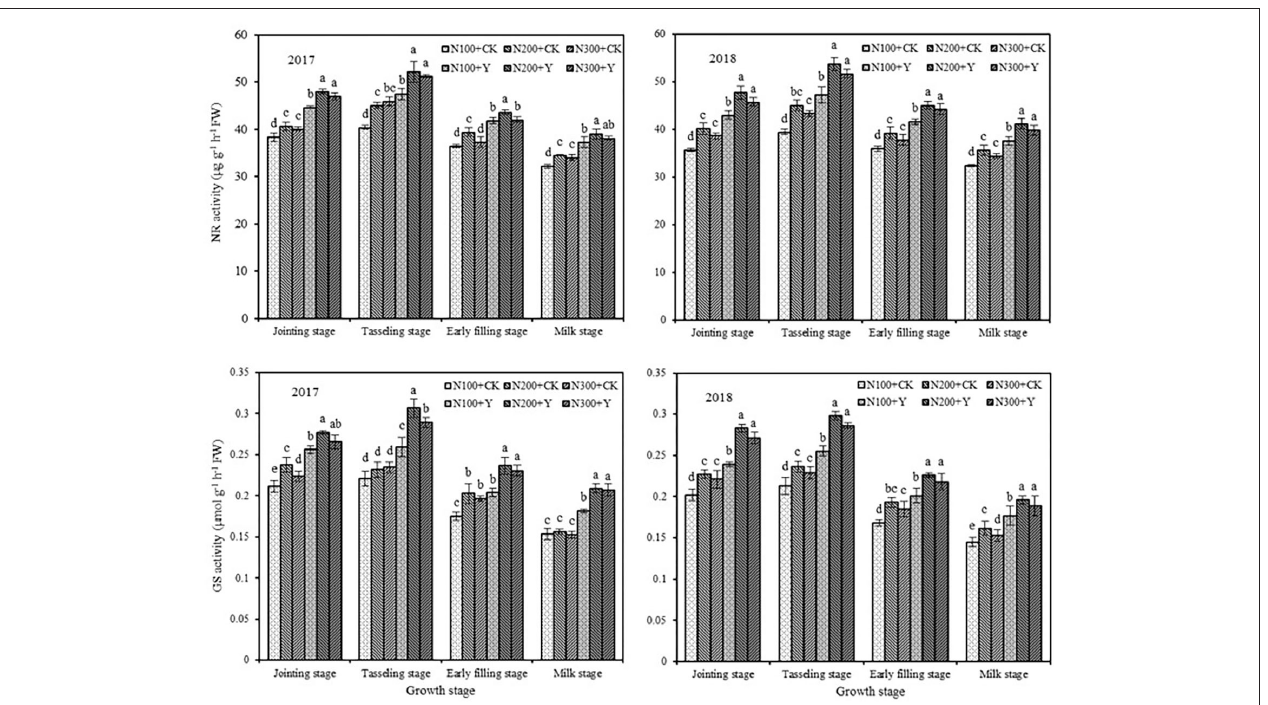
FIGURE 3 | Effects of chemical control and nitrogen fertilizers on NR and GS activities in ear leaf during the maize growing period in 2017 and 2018. N100 + CK, N200 + CK, and N300 + CK indicate nitrogen applied levels at 100, 200, and 300kg ha − 1 under water treatment, respectively; N100 + Y, N200 + Y, and N300 + Y indicate nitrogen applied levels at 100, 200, and 300kg ha − 1 under chemical control, respectively. Error bars indicate the value of standard error. Different letters within a growth stage indicate a significant difference at P <